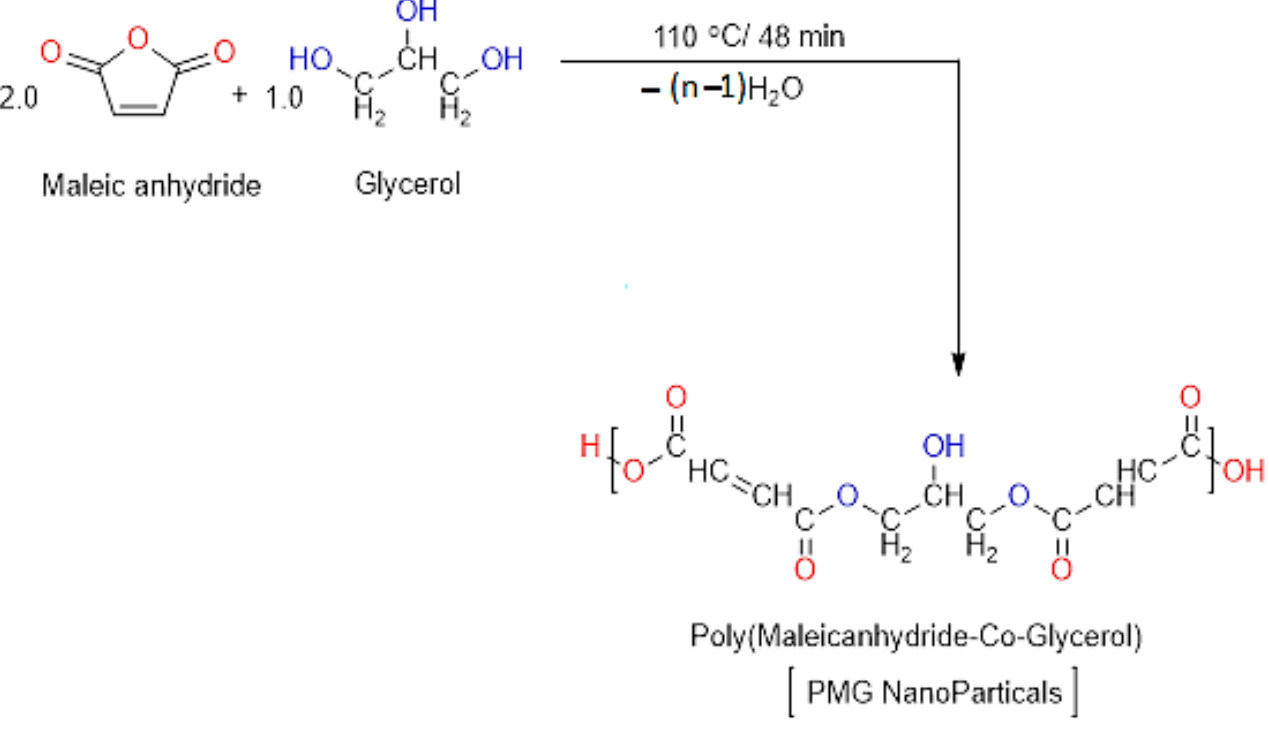
Figure 1. Reaction of synthesized PMG nano copolymer.